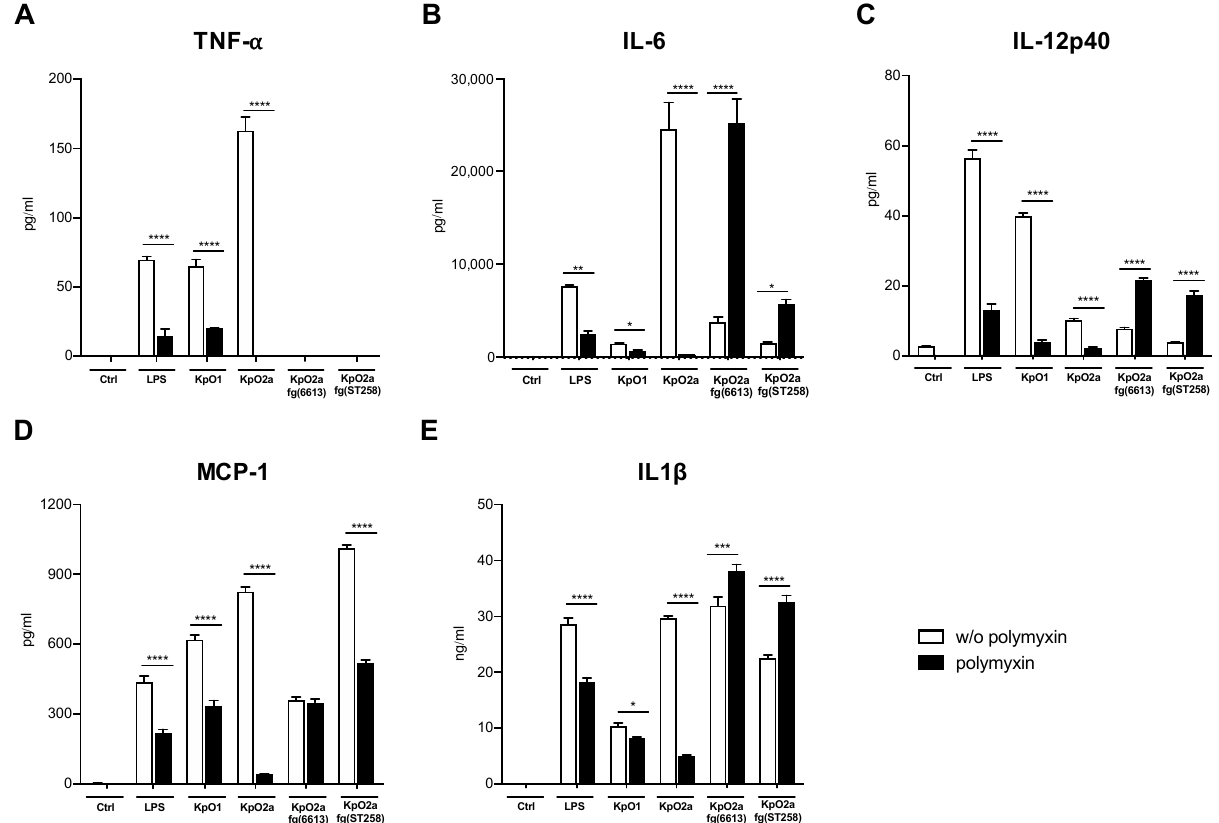
Figure 3. Whole blood cells were stimulated with 1 µg/mL of each of the K. pneumoniae purified LPS KpO1, KpO2, KpO2afg (6613) and KpO2afg (ST258) for 6 h ( A – E ). LPS refers to E. coli 0111:B4 commercial LPS used at the same concentration as the K. pneumoniae LPS. Results are representative of four different donors. The results are expressed as the average ± SEM. Statistical analysis was performed using one-way ANOVA, * p < 0.05, ** p < 0.01, *** p < 0.001 and **** p <